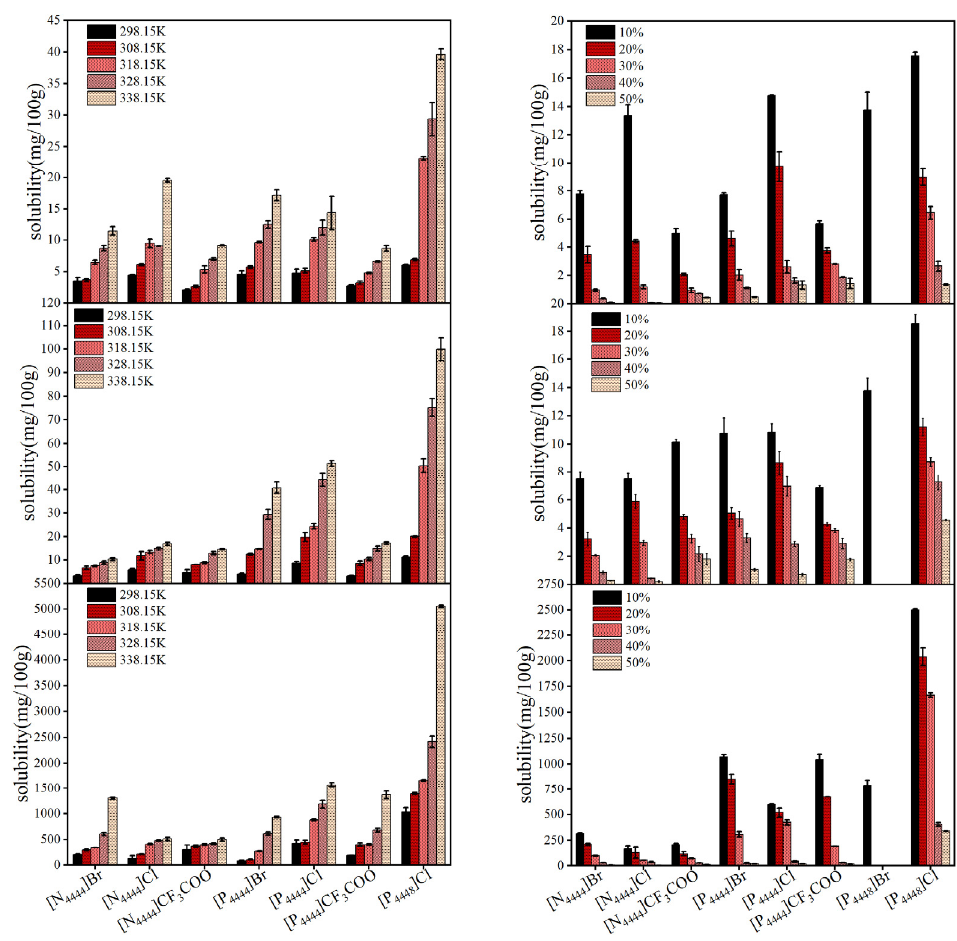
Figure 2. Solubility of astaxanthin ( top ), β -carotene ( middle ), and lutein ( bottom ) in the IL aqueous solutions as a function of temperature ( left , w water = 20%) and water content ( right , T = 298.15 K).